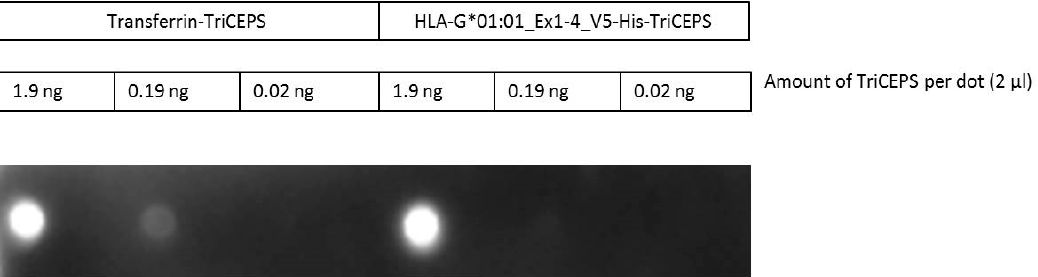
Figure A3. The viability of NKL cells is not impaired by the coupling buffer. The effect of incubation with the coupling buffer on the viability of the target cells was examined. Dead cells are stained with 7-AAD.